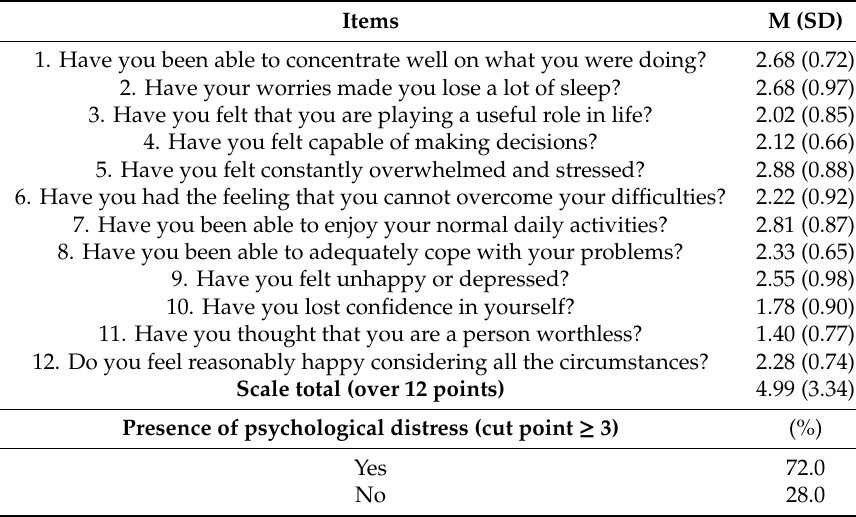
Table 1. General Health Questionnaire GHQ-12 (N =